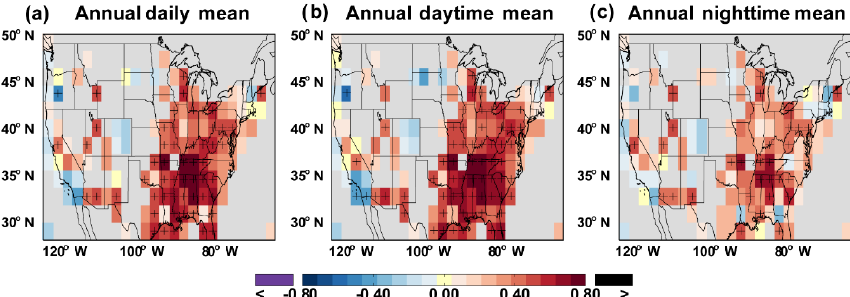
Figure 7. Correlation in interannual variability over 1990–2014 between the annual AMONI index and the annual average daily mean ozone (a) , daytime mean ozone (b) , and nighttime mean ozone (c) . All data are detrended prior to correlation calculations. Correlations are statistically significant ( P value<0.05 after a one-sided t test) in grid cells overlaid with + . The grid cells in grey have no AQS data.